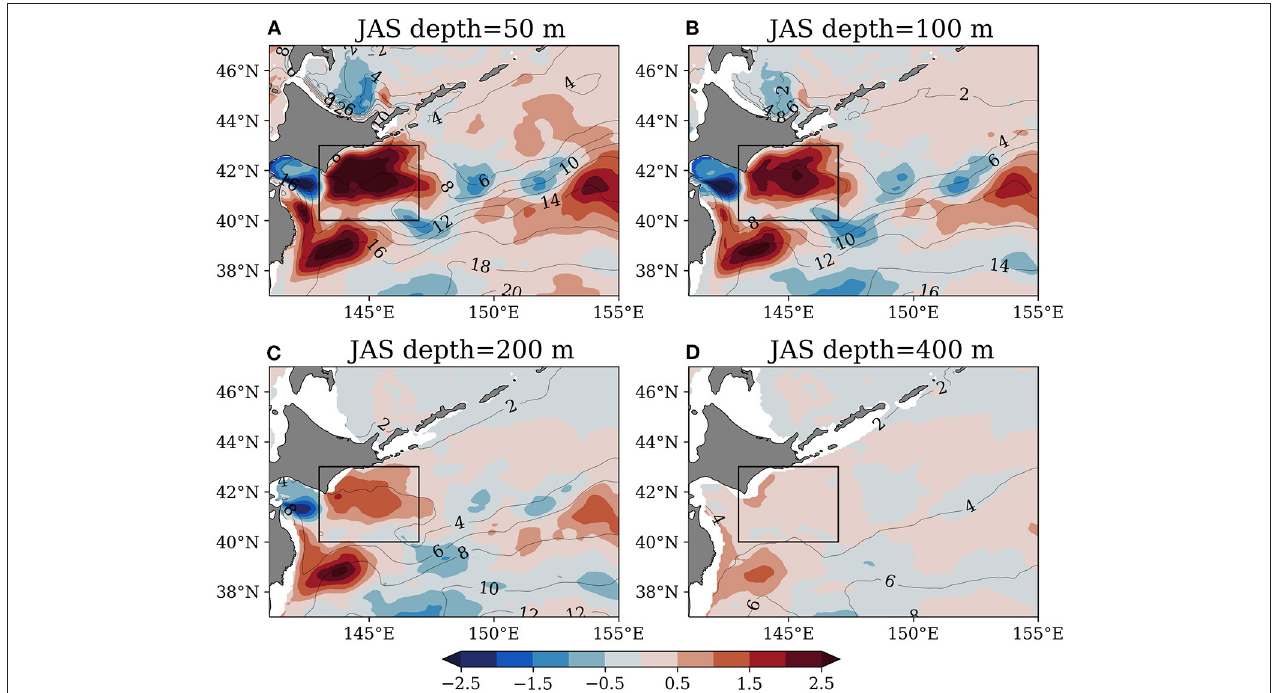
FIGURE 8 | Deviation of the 2010–2016 average temperature at each depth from the 1993–2009 average (color; ◦ C) and the 2010–2016 average temperature at each depth (contour, ◦ C) of the FRA-JCOPE2 reanalysis. (A) At 50m. (B) At 100m. (C) At 200m. (D) At 400m.